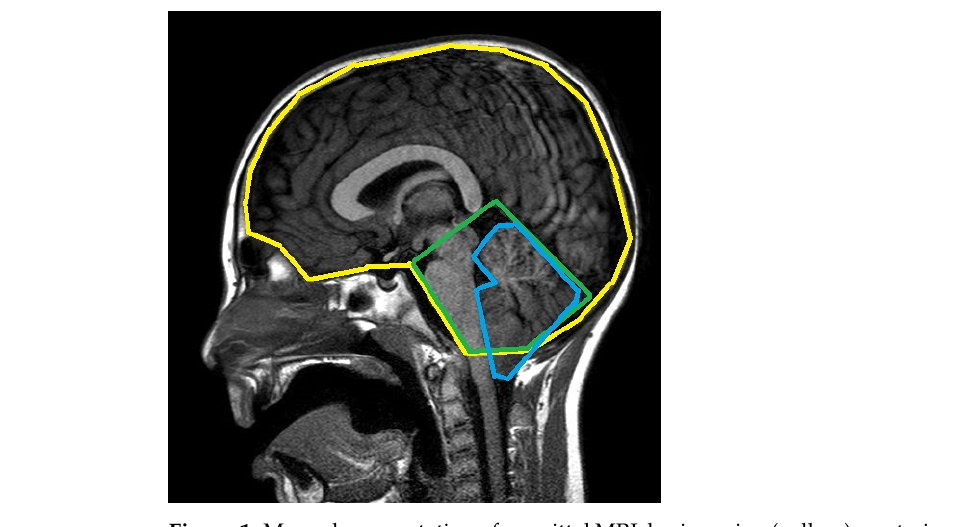
Figure 1. Manual segmentation of a sagittal MRI: brain region (yellow), posterior cranial fossa (green), cerebellum area